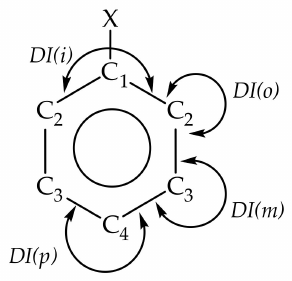
that we have considered a symmetric Ph–X system.